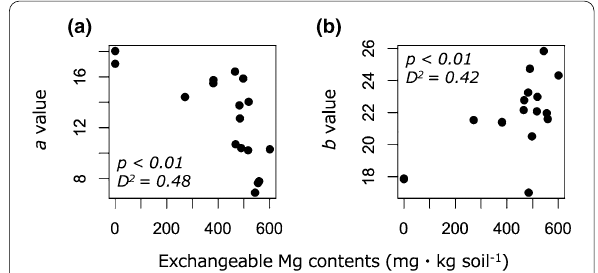
Fig. 1 Relationship between colour values ( a and b ) of Juglans mandshurica var. sachalinensis and exchangeable Mg contents in soil. The statistical significance of the relationship was shown as p value analysed with GLM. The fitness of the GLM was defined with D 2 value following